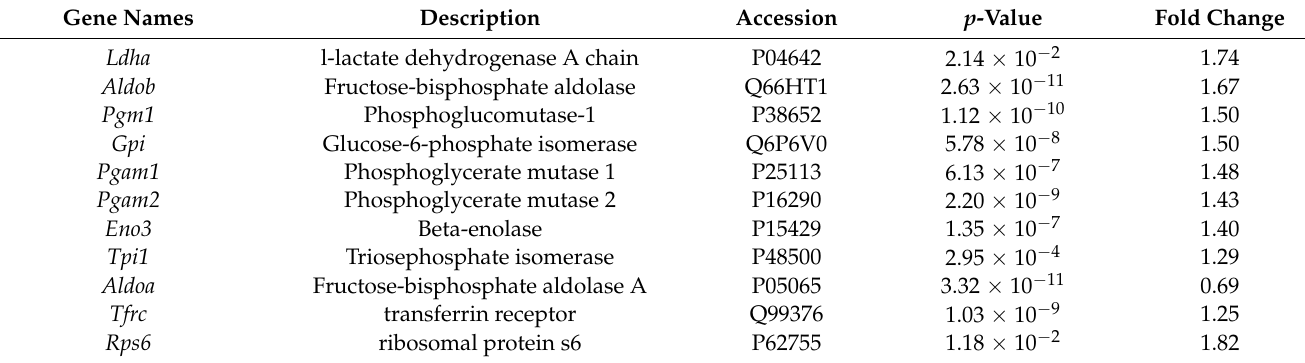
Table 1. The differential expressed proteins enriched in the glycolysis/gluconeogenesis and HIF-1 signaling